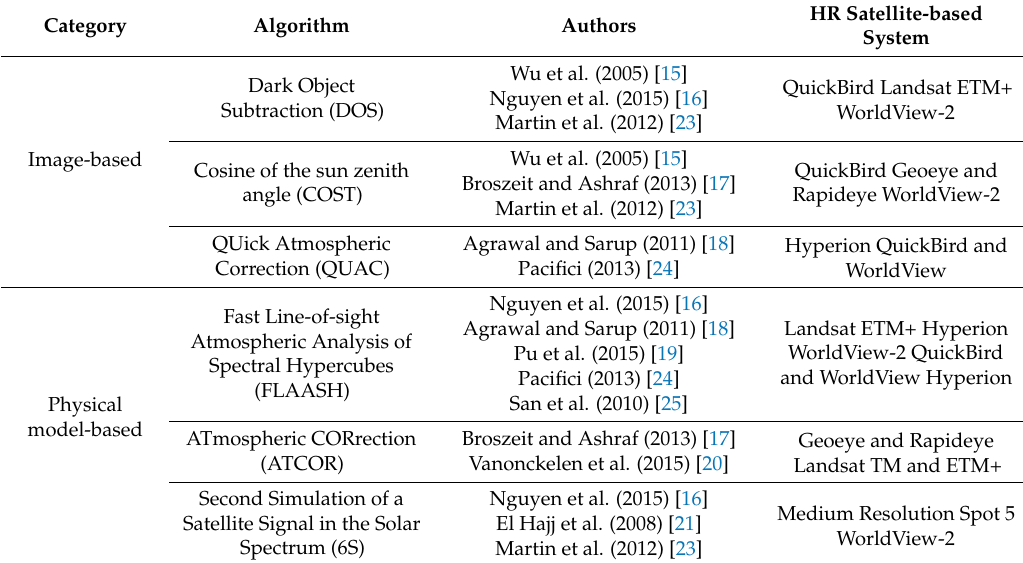
Table 1. Review of recent atmospheric correction studies categorized as image-based and physical